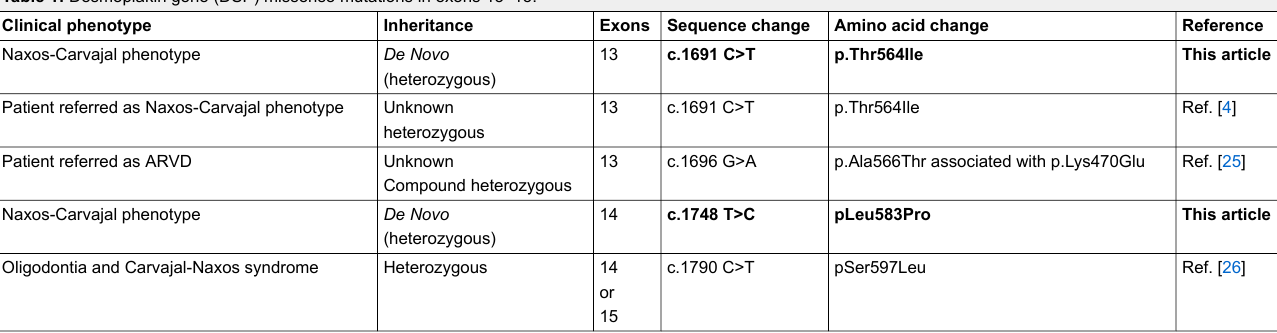
Table 1: Desmoplakin gene (DSP) missense mutations in exons